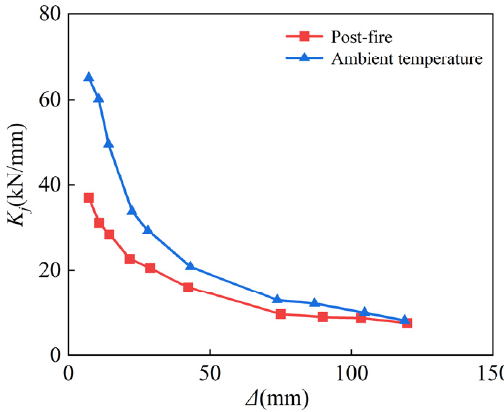
Figure 13. Stiffness